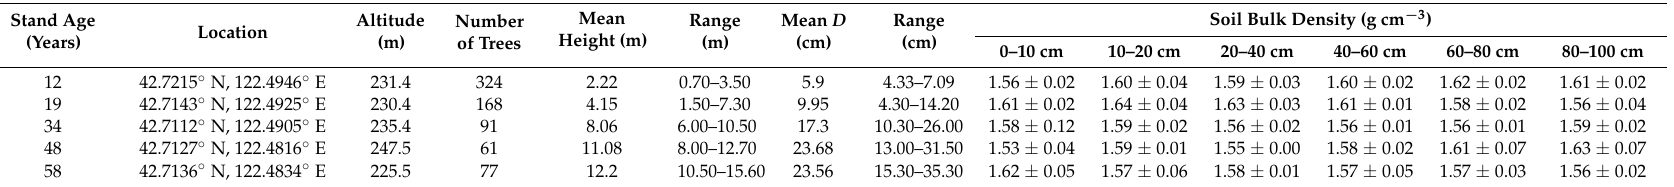
Table 1. Stand characteristics (the mean value with the standard error) of the 12-, 19-, 34-, 48-, and 58-year-old Mongolian pine ( Pinus sylvestris L. var. mongolica Litv.)